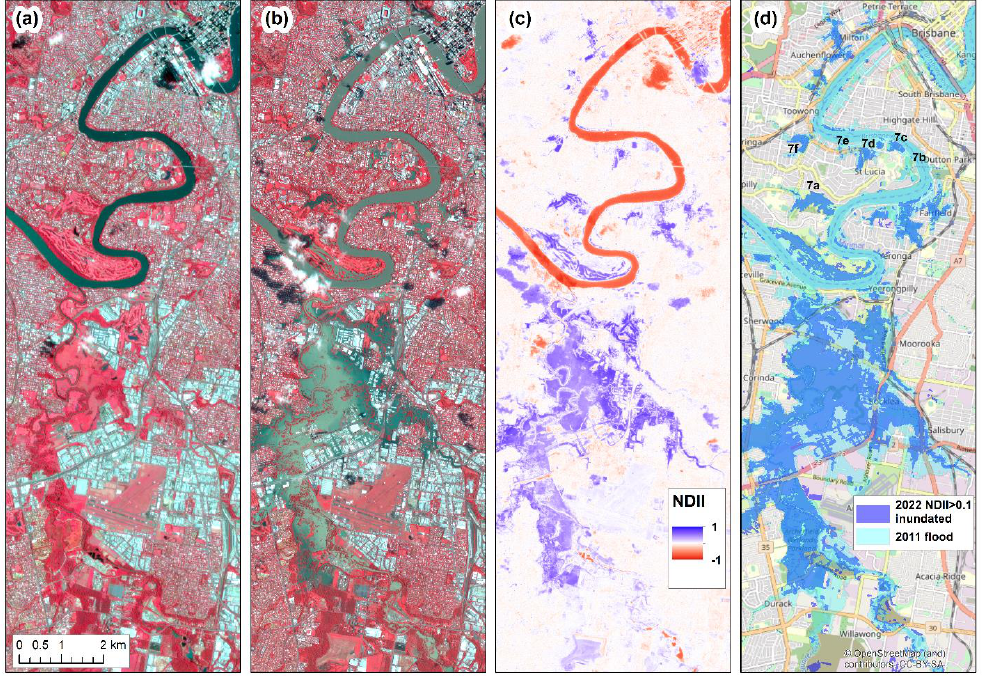
Figure 6. ( a ) Pre-flood PlanetScope image, 9 February 2022, showing the area from Brisbane’s CBD in the north, through the St. Lucia campus of the University of Queensland, to the flood plain of Oxley Creek in the south; ( b ) Peak-flood PlanetScope image, 28 February 2022; ( c ) NDII map; ( d ) Comparison between the 2011 flood, and the areas inundated in 2022 (after removal of false- positives). The approximate locations of photos taken on 28 February 2022 are shown here, the photos are presented in Figure 7.